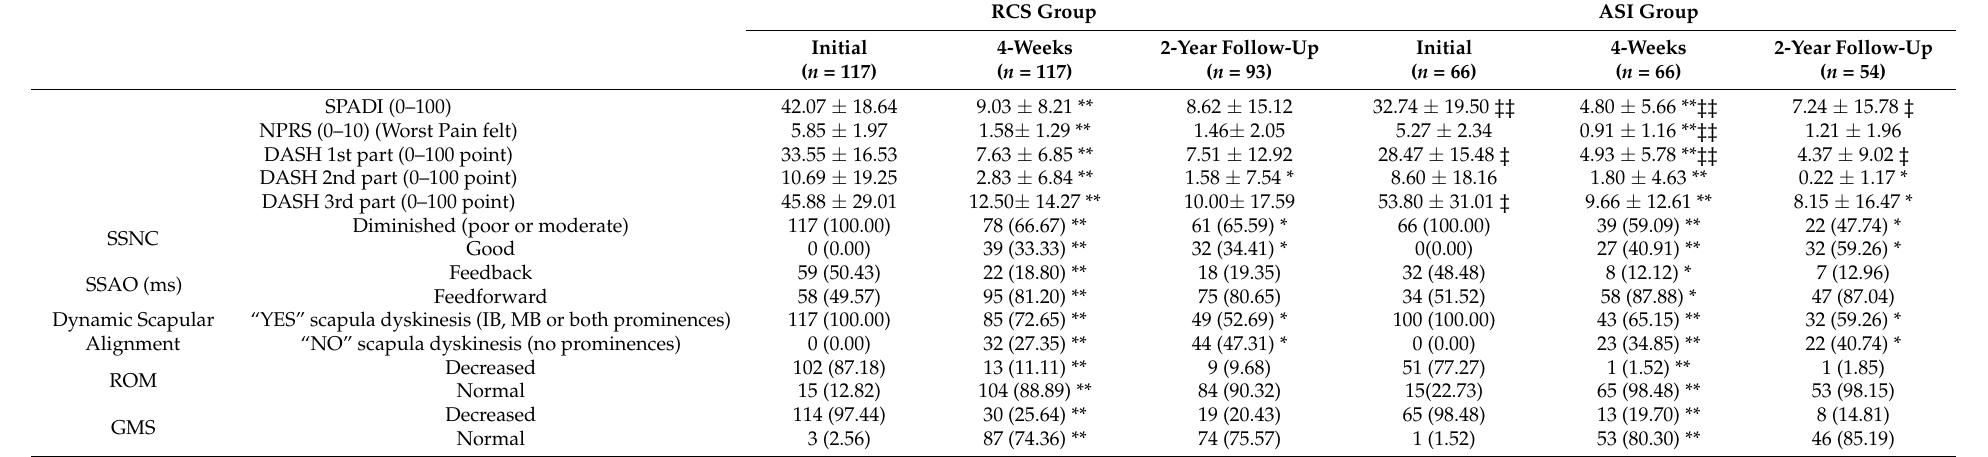
Table 3. Comparison of outcomes within groups and